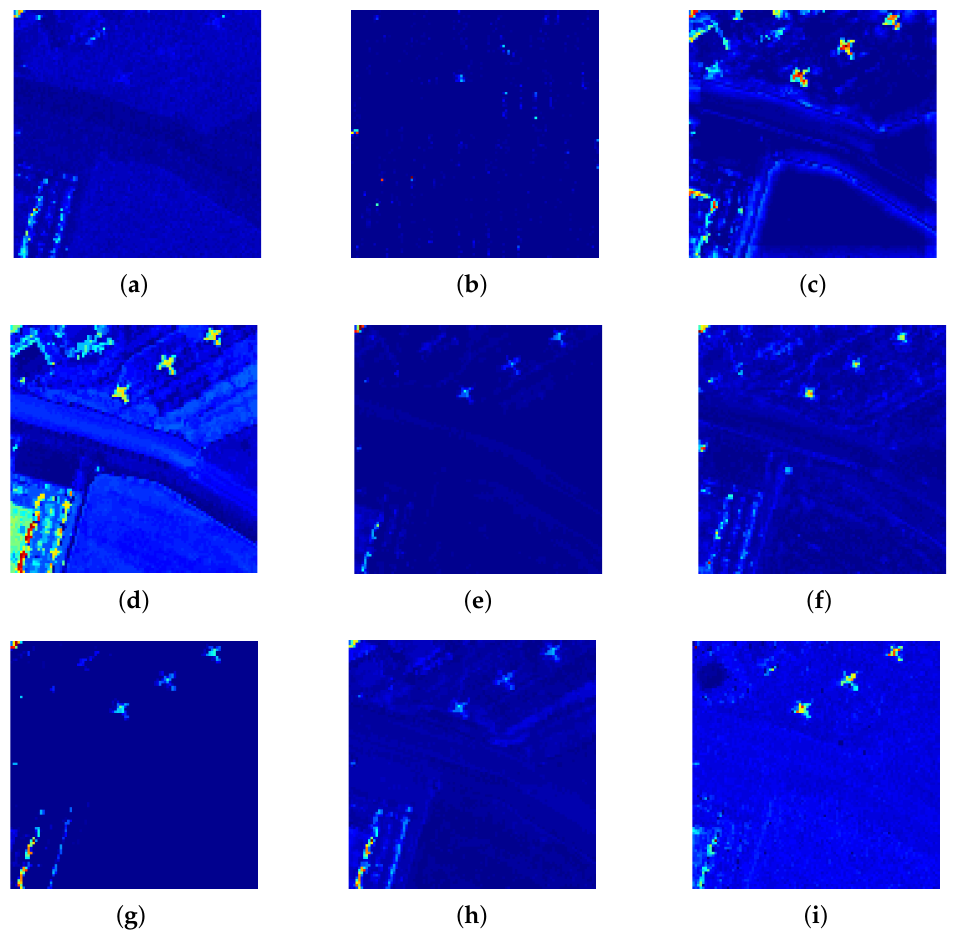
Figure 15. Color detection maps of all compared algorithms for the San Diego dataset. ( a ) RX; ( b ) LRX;